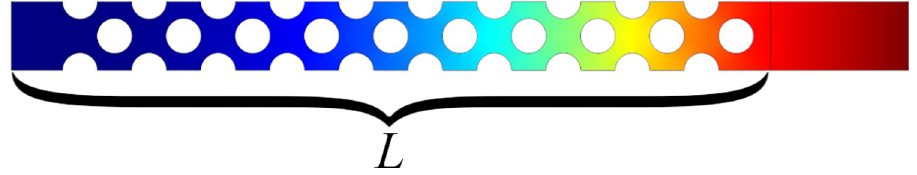
Fig 2. An example of the Comsol model geometry. The circles represent phages and the colour scale indicates antibiotic concentration (with high to low concentration represented by the colours from red to blue). The phages form a lattice of repeating unit cells. The tactoid width L is